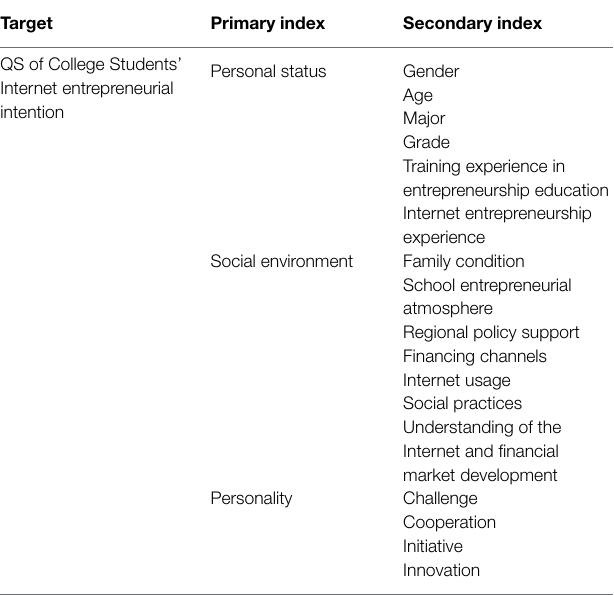
TABLE 1 | Questionnaire form for College Students’ Internet entrepreneurial